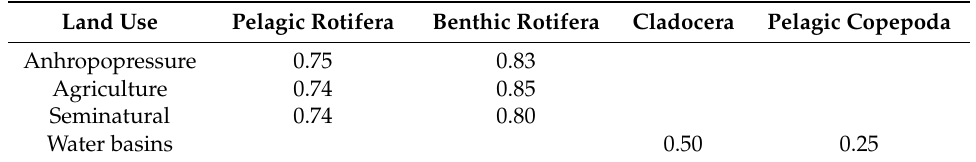
Table 6. Spearman significant correlations with Holm’s correction between zooplankton abundance (ind. l − 1 ) and percentage land use in the total catchment area (ha).